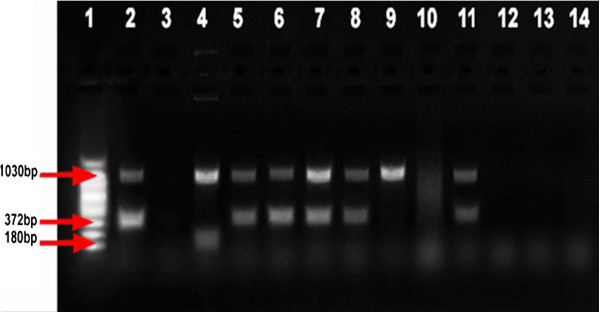
Gel electrophoresis separation of PCR products of multiplex PCR genus typing on mycobacteria isolates from pigs. Lane 1:100 bp DNA Ladder; Lane 2: M. tuberculosis H37Rv (positive control); Lane 3: Qiagen H2O (negative control); Lane 4: M. avium (positive control); Lanes 5–14 sample isolates from pigs.